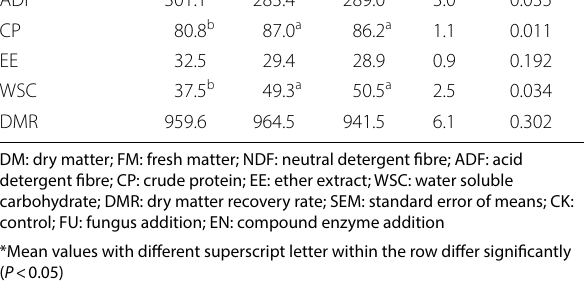
Table 5 Effects of different additive treatments on the in vitro crop maize silage after 30 days fermentation